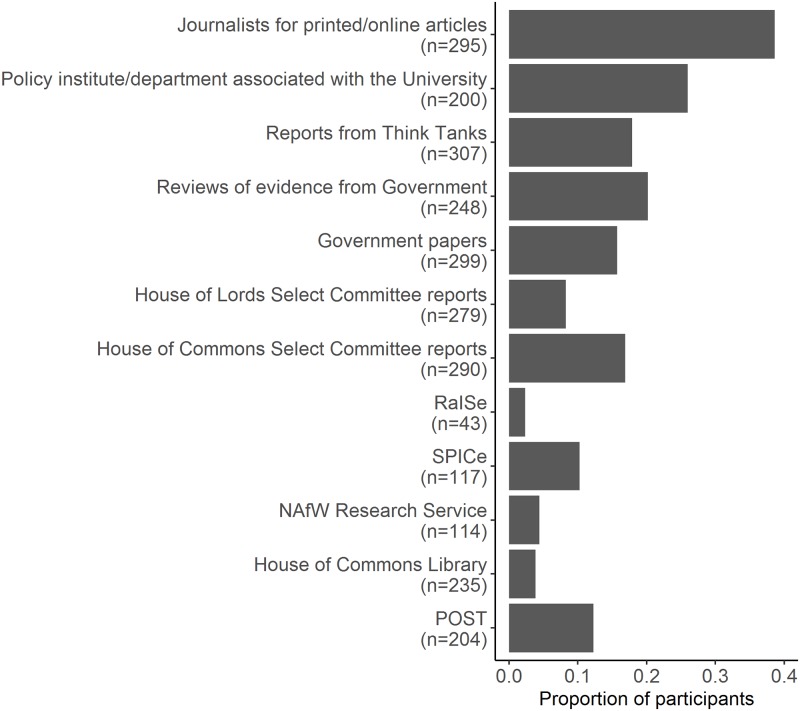
The proportion of participants that reported previous engagement that had at least heard of the option.Number of individual respondents who had at least heard of the option indicated in the y-axis. Abbreviations: RaISe, Northern Ireland Assembly Research and Information Service; SPICe, Scottish Parliament Information Centre; NAfW, National Assembly for Wales; POST, Parliamentary Office of Science and Technology.